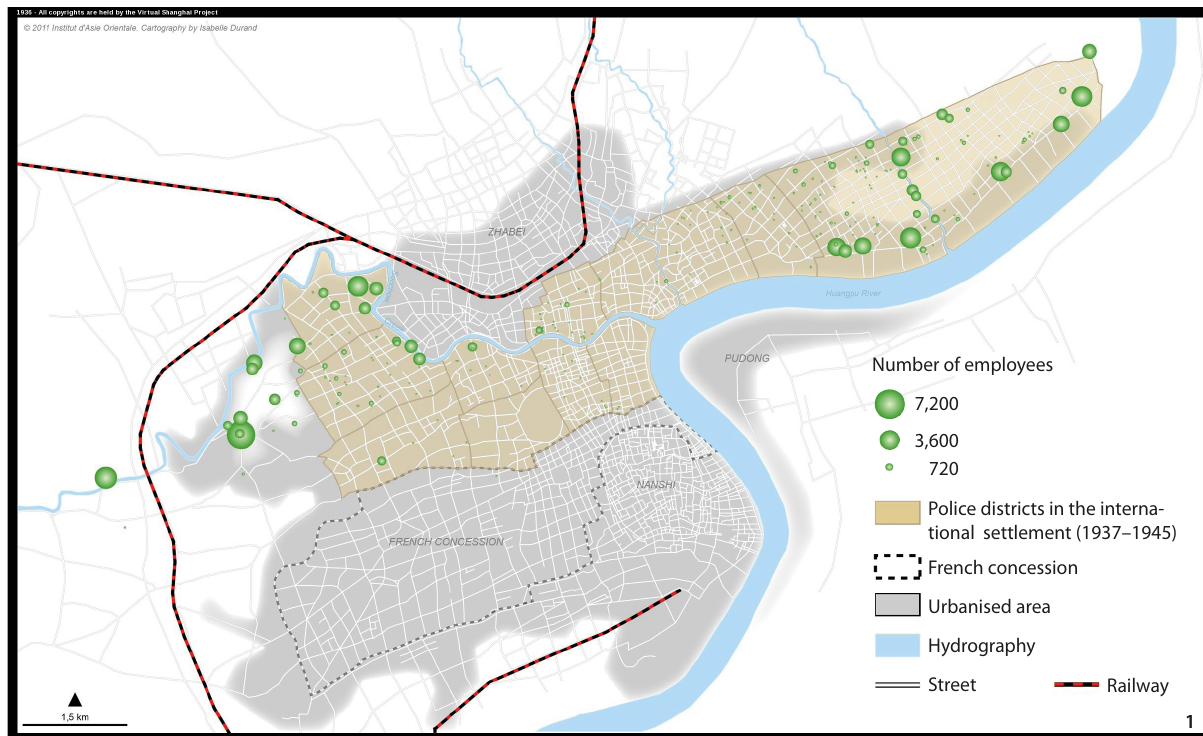
Figure 1 Concentration of Textile Workers, Shanghai, 1936 (Source: